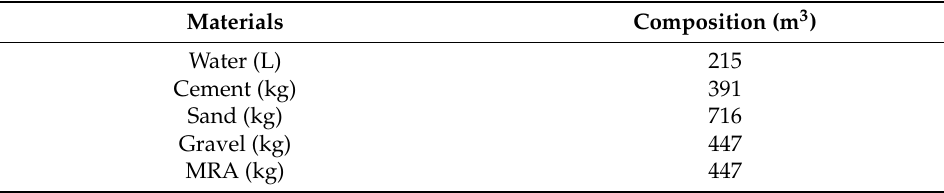
Table 1. Recycled concrete composition per m 3 .